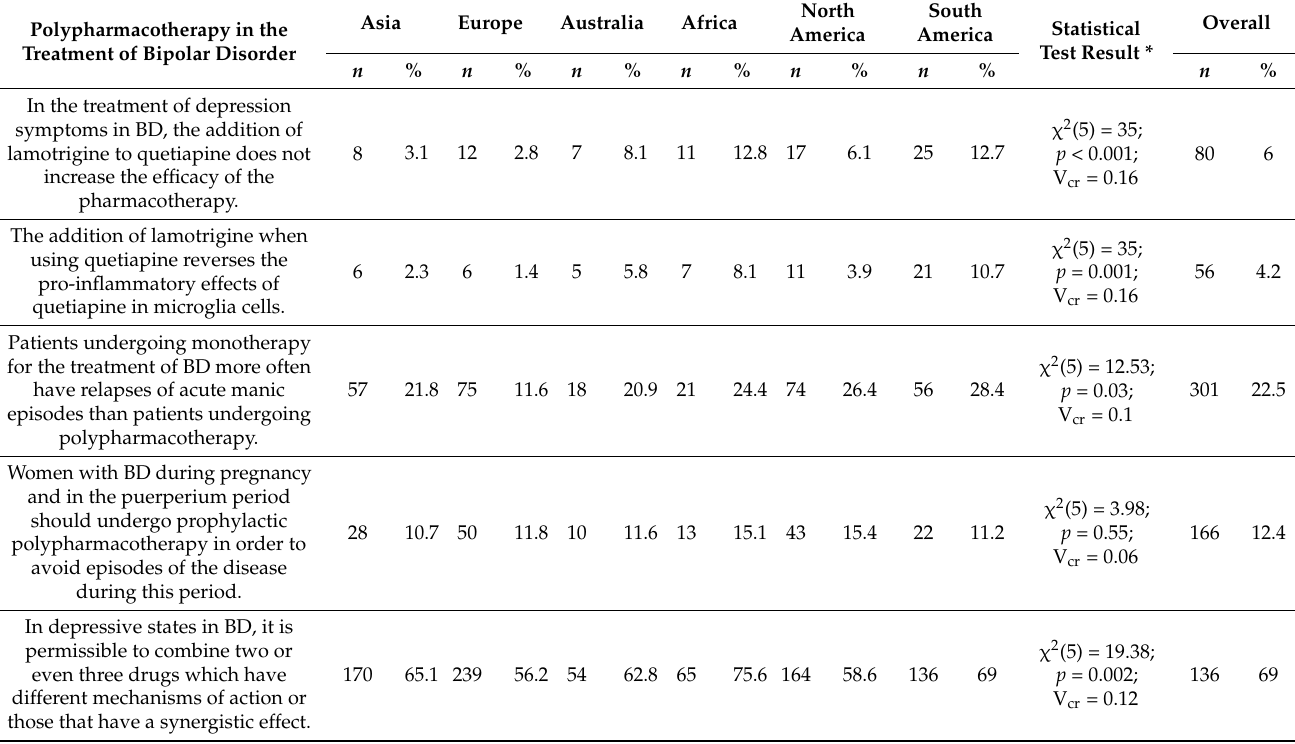
Table 6. Psychiatrists’ answers on the polypharmacotherapy in the treatment of bipolar